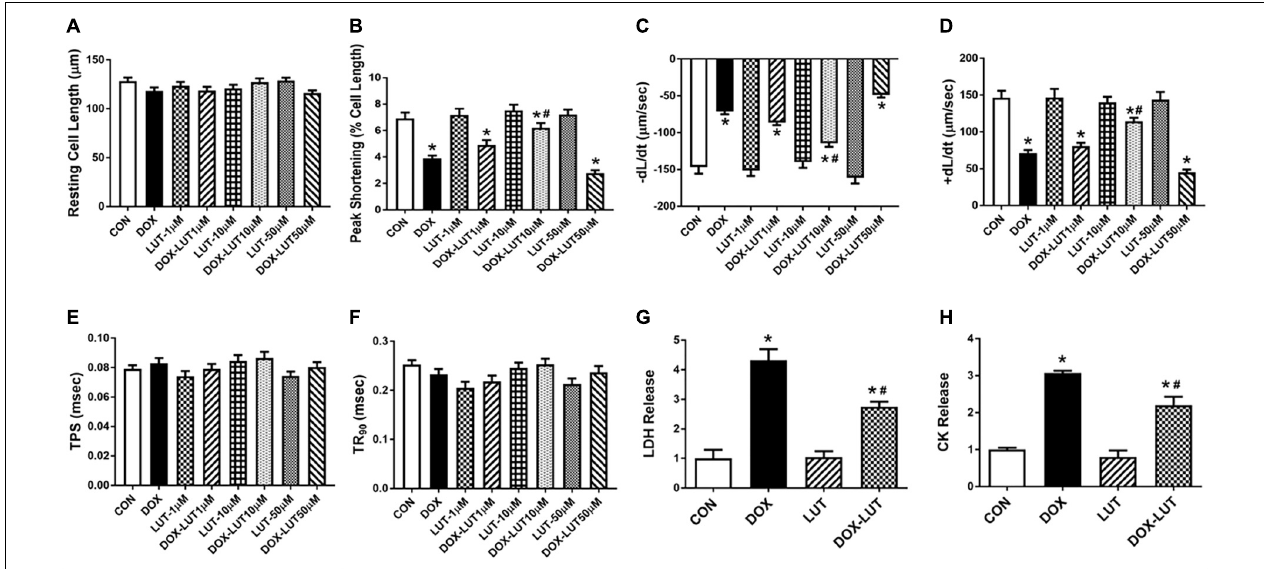
FIGURE 1 | Cardiomyocyte contractile function and cell injury following doxorubicin and luteolin (at various concentrations) exposure for 24 h. (A) Resting cell length; (B) Peak shortening (PS); (C) Maximal velocity of shortening (–dL/dt); (D) Maximal velocity of relengthening (+dL/dt); (E) Time-to -peak shortening (TPS); (F) Time-to-90% relengthening (TR 90 ); (G) LDH; and (H) CK. Mean ± SEM, n = 30 cells each group from three independent experiment. * p < 0.05 vs. CON group, # p < 0.05 vs. DOX group.